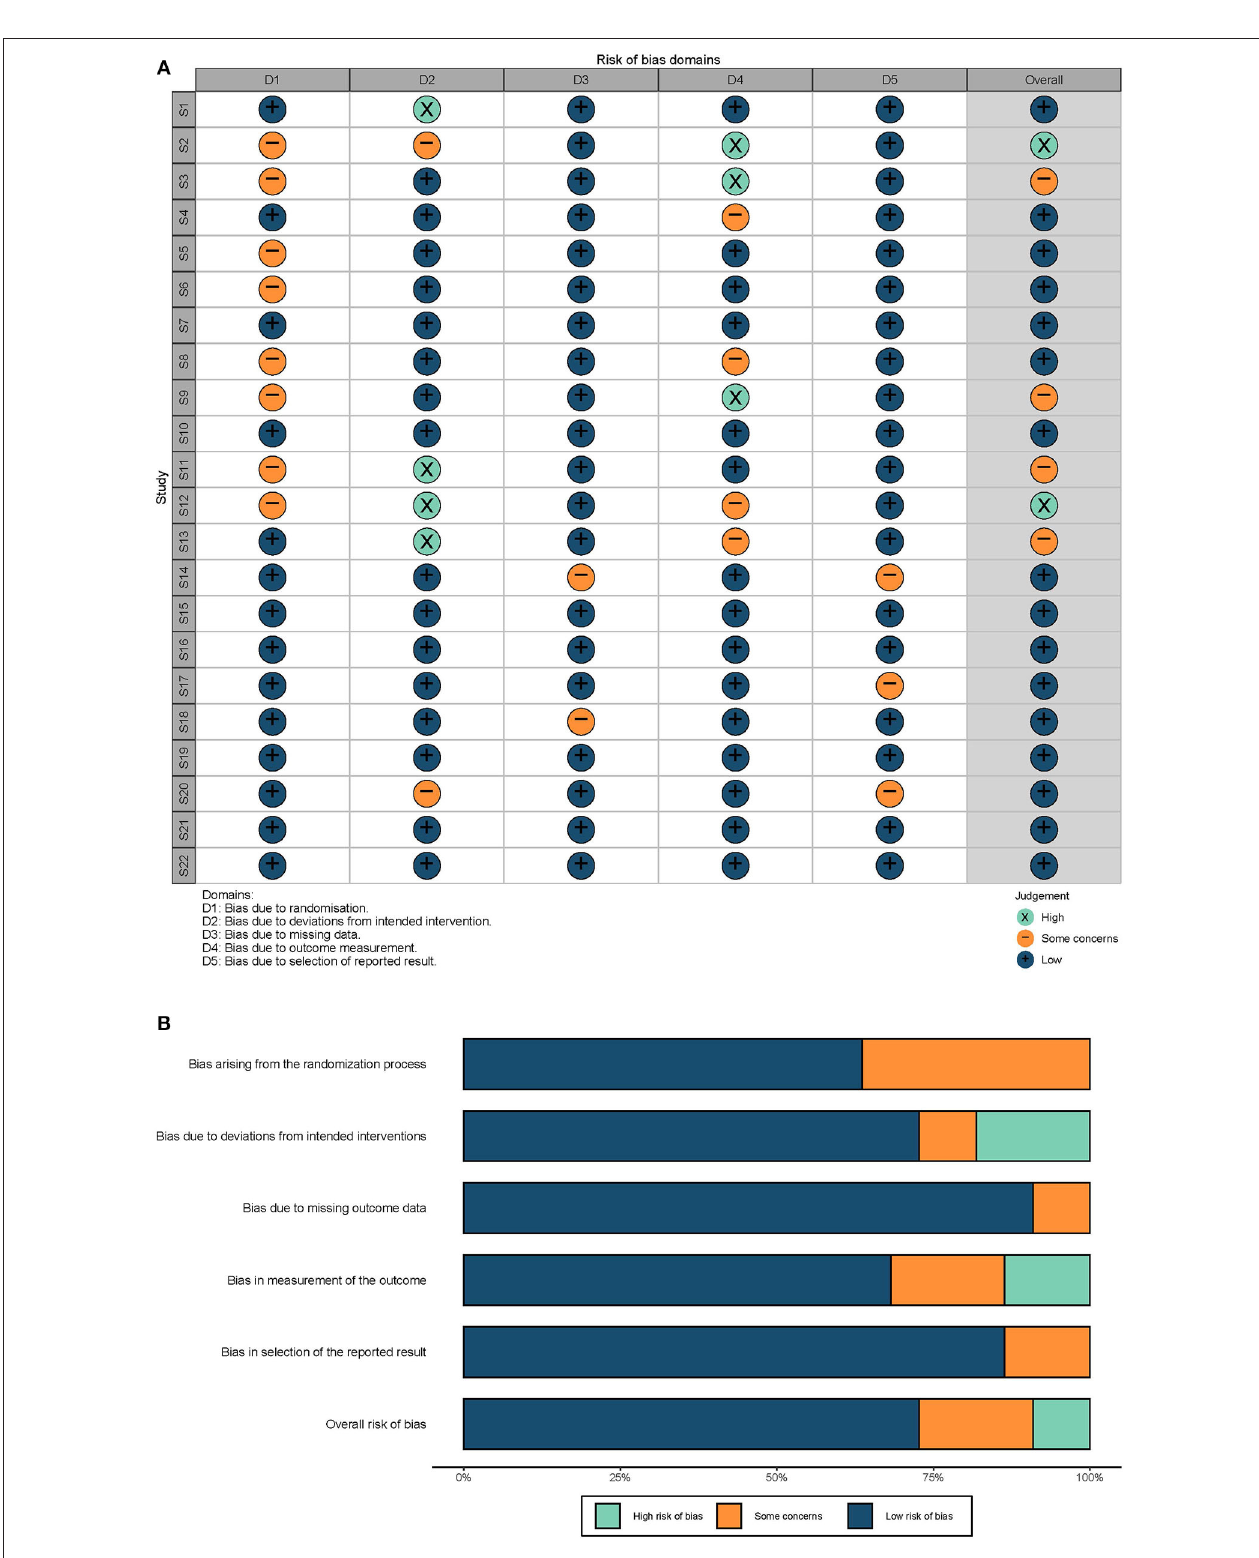
FIGURE 2 | Quality evaluations. (A) Risk biases of each study. S1–S22: 22 studies included in this review, serially. The overall risk was evaluated based on the criteria described previously. (B) Summary of risk biases. The length of each color represents the proportion of the risk.